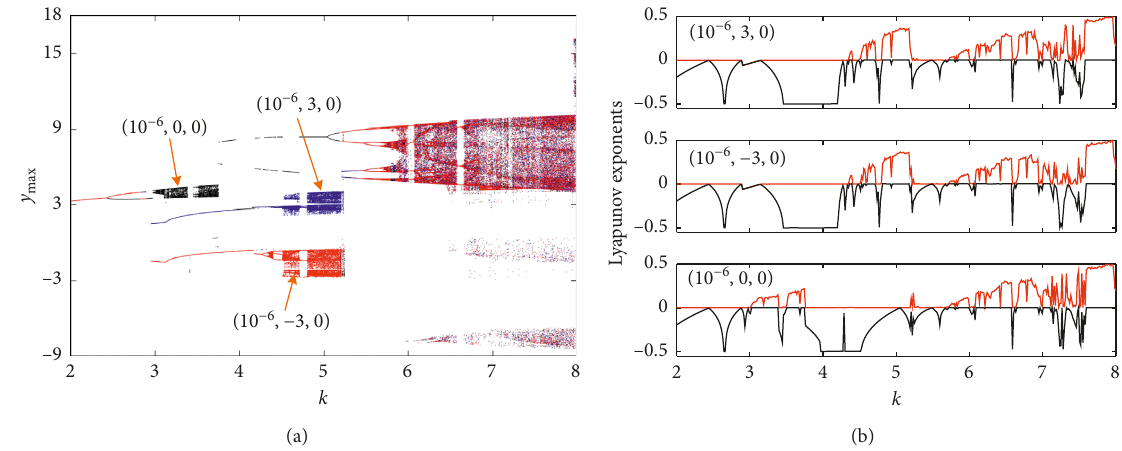
Figure 6: Two-dimensional spectral entropy-based complexity plots for the variable x sequence in the k of initial values. (a) Initial values (10 − 6 , 0, 0). (b) Initial values (10 − 6 , 3, 0).